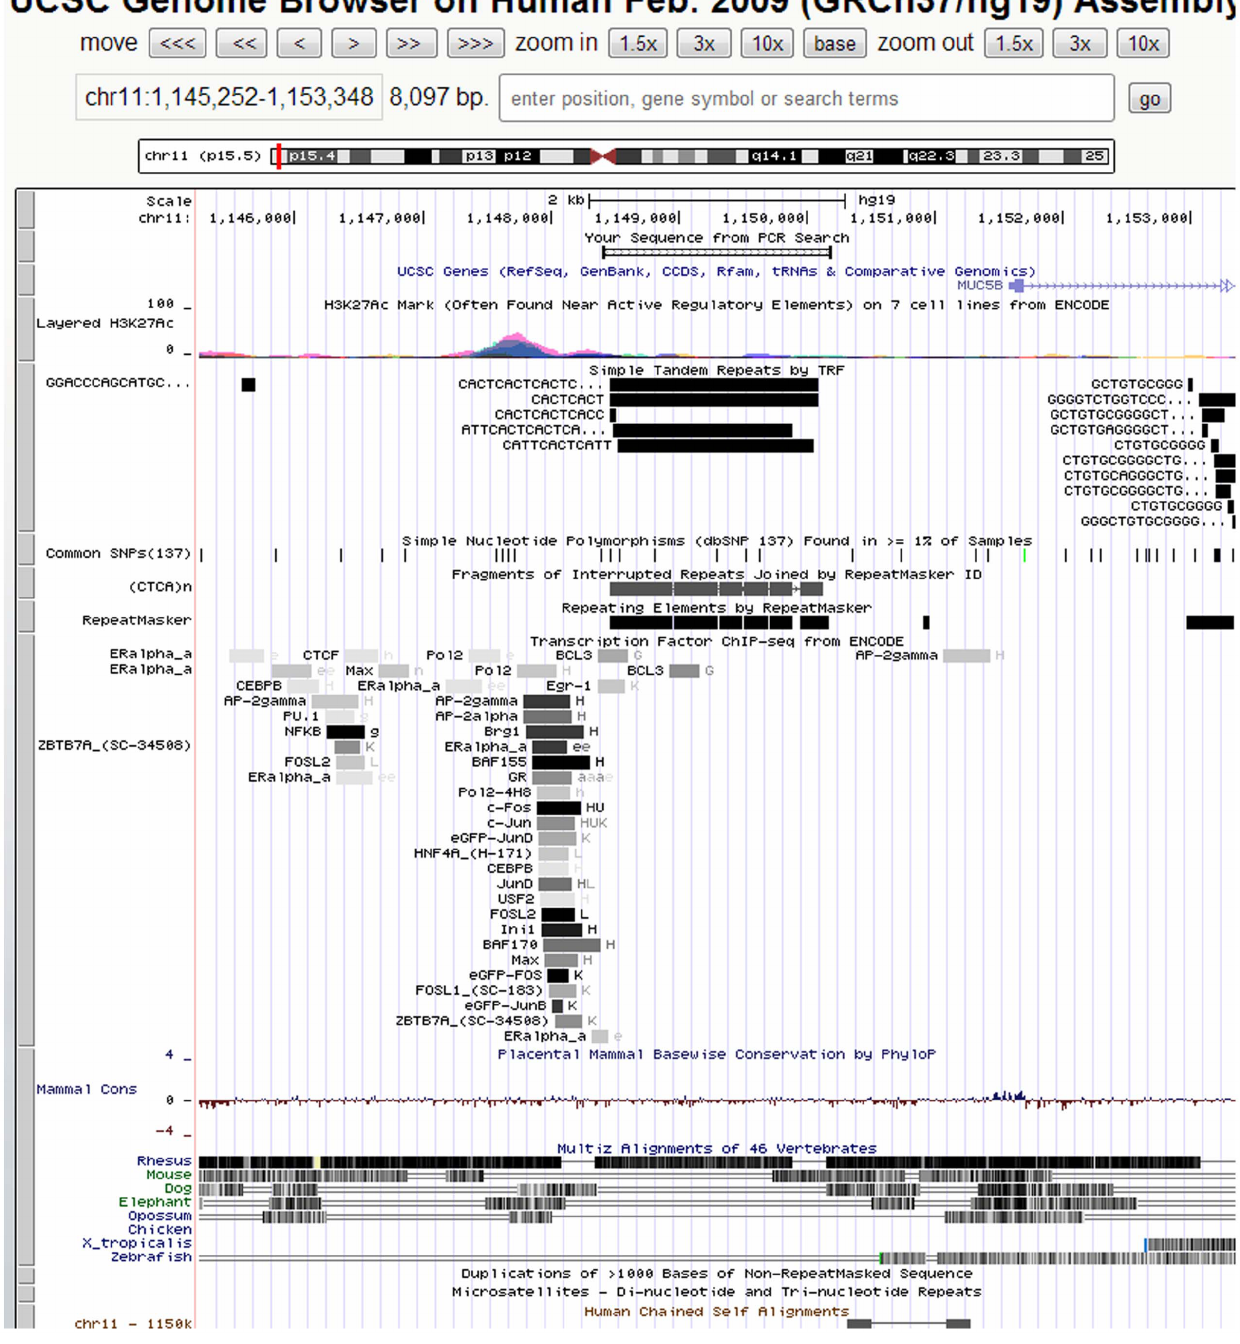
Figure 1. Location and genomic features of the upstream region of the human MUC5AC gene. The studied MUC5AC-u repetitive region (red and black boxes) is located about 1.5 kb upstream from the MUC5AC mRNA transcript start, the MUC5AC transcript is incorrectly annotated to MUC5B (UCSC Genome Brower, GRCh 37/hg 19). This locus snapshot illustrates its location, the PCR coverage in amplifying the target region (open box with vertical lines), the major repetitive genomic features defined by Repeat Master, the histone H3 lysine 27 acetylation (H3K27AC) enrichment and reported transcription factor binding sites, and many more other features.